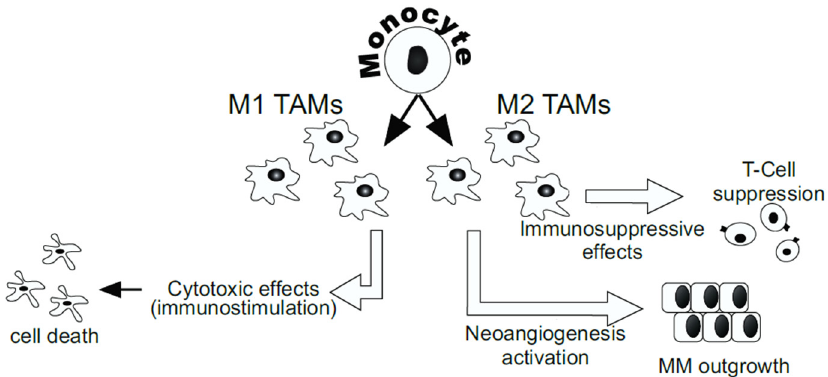
Figure 2. Role of the innate immunity in the development of MM. Tumor ‐ associated macrophages (TAMs) represent a major link between inflammation and cancer. The majority of TAMs in MM have the M2 phenotype. M2 TAMs have poor antigen ‐ presenting capacity, suppress T ‐ cells adaptive immunity, and support MM